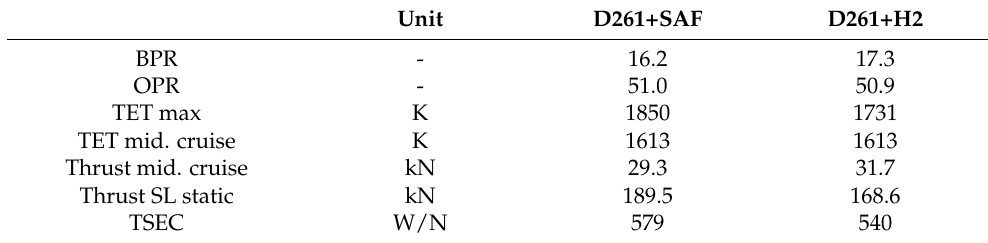
Table 4. Turbofan Performance Characteristics.